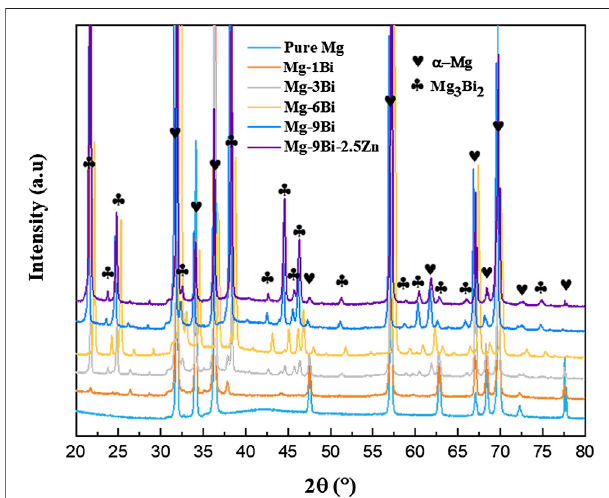
FIGURE 5 | XRD pro fi les of pure Mg, Mg-Bi, and Mg-Bi-Zn alloys.